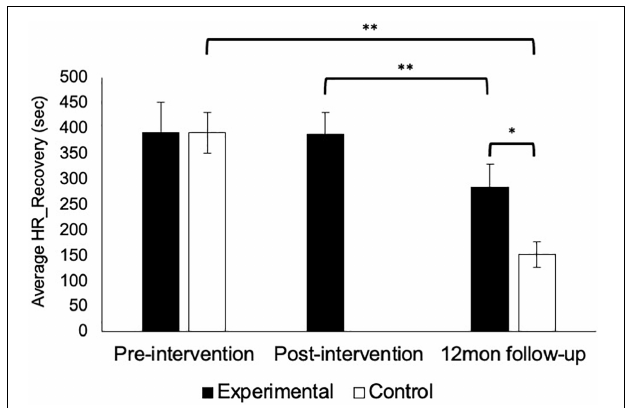
FIGURE 4 | Recovery from peak autonomic activation following critical incident scenarios. HR_Recovery did not significantly change following a 1-day AM intervention, but was faster at 12-month follow-up ( p = 0.006). Participants in the control group also showed faster HR_Recovery at 12-month follow-up relative to pre-intervention values ( p = 0.001), which was also faster than the experimental group at uncorrected significance levels ( p = 0.012). Error bars show standard error of the mean. ∗∗ p < 0.01, ∗ p < 0.05.